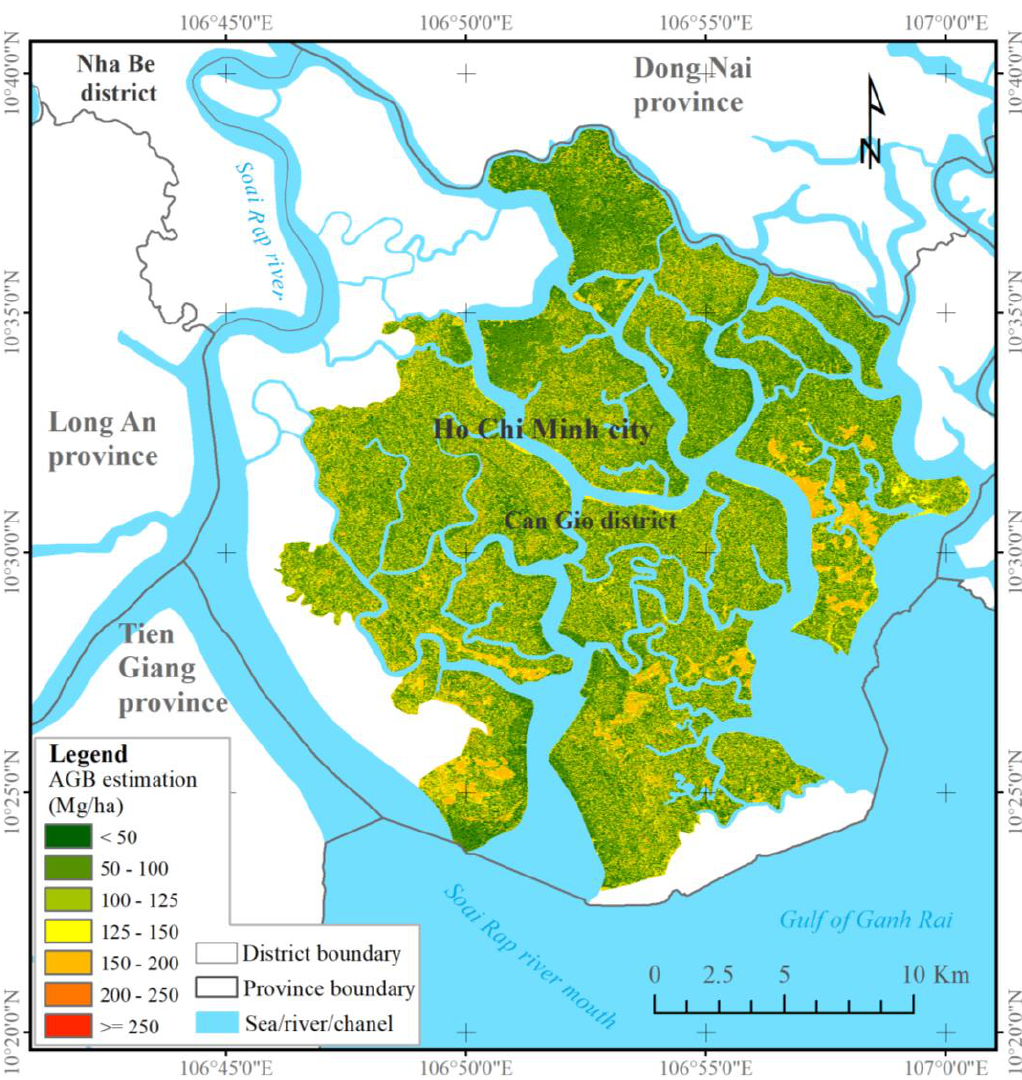
Figure 7. Estimated spatial distribution of mangrove AGB in the study area.